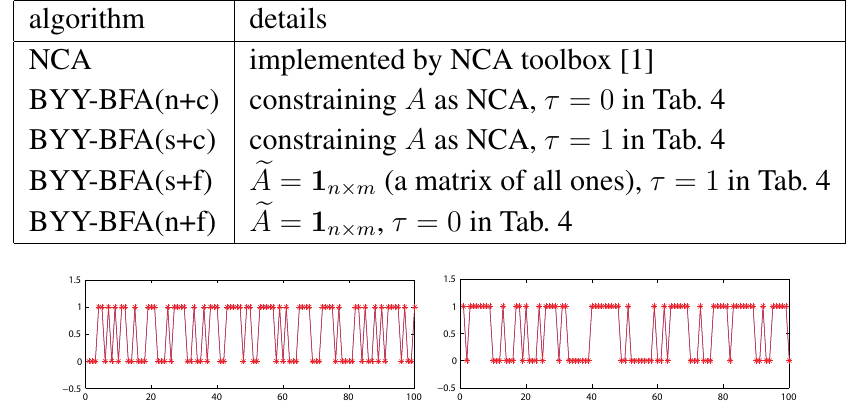
Table 1: Implementation of the algorithms. ”c”: constraining A with the connectivity topology from e.g., ChIP-chip assay; ”f”: using a full A (no a priori connectivity); ”n”: implementing BYY-BFA without sparse prior; ”s”: implementing BYY-BFA with sparse prior.